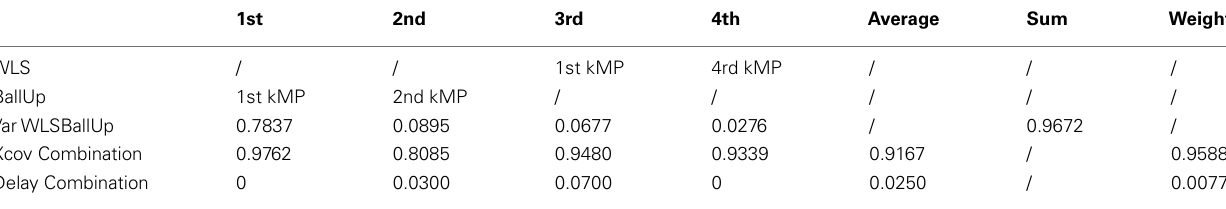
TableA9 | Combination of the kMPs of walking and the kMPs of reaching (2